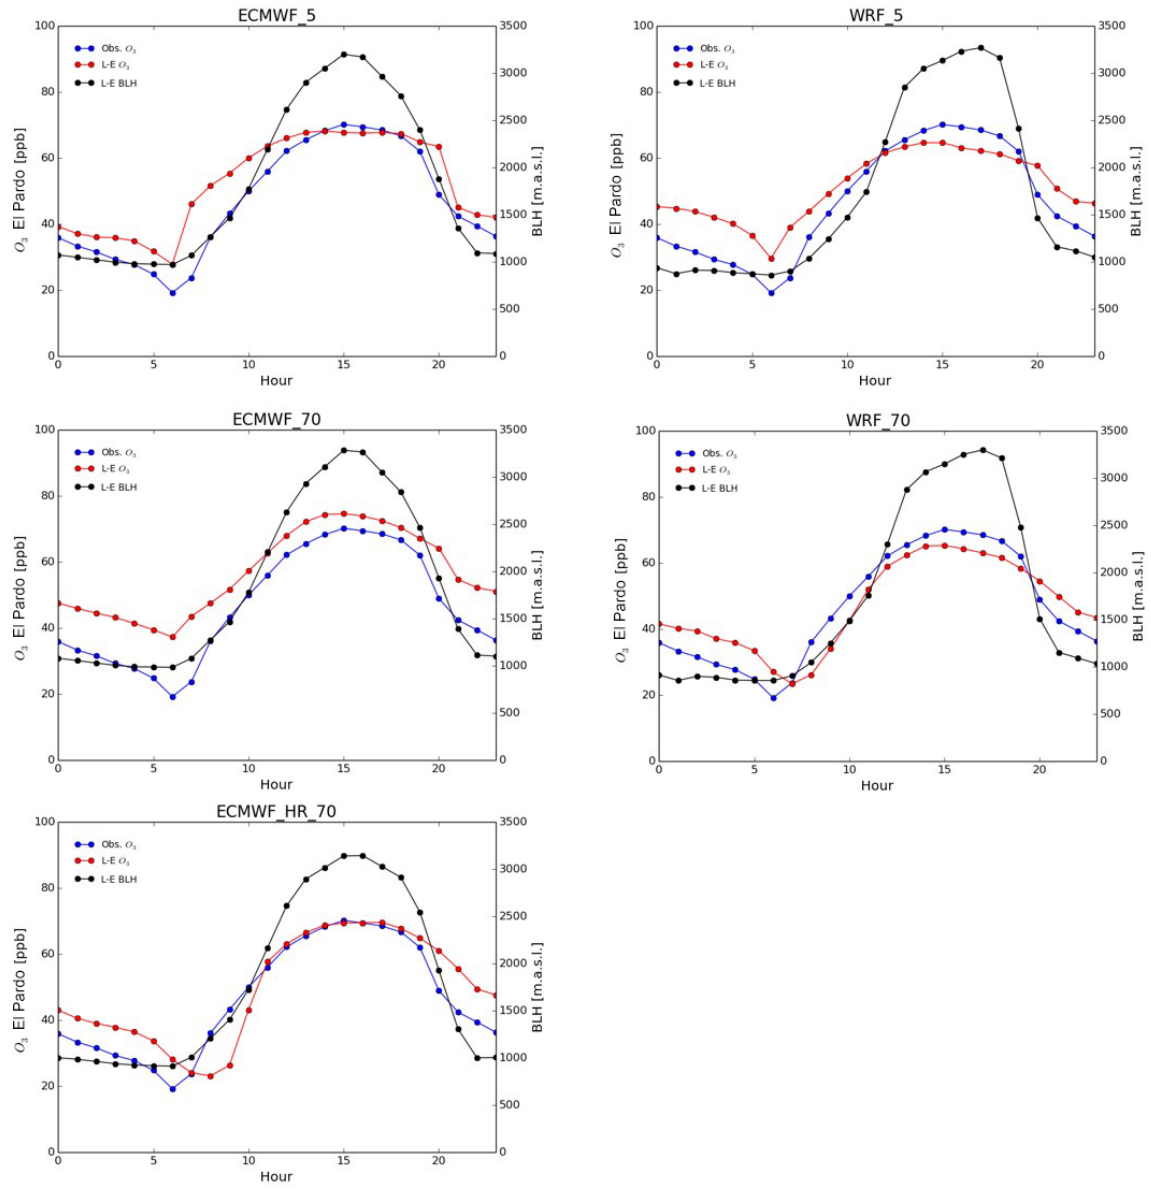
Figure 3. Simulated average diurnal cycles obtained from the five LOTOS-EUROS configurations compared with the mean cycle from the observations in the El Pardo background station. The modelled evolution of the boundary layer height is also